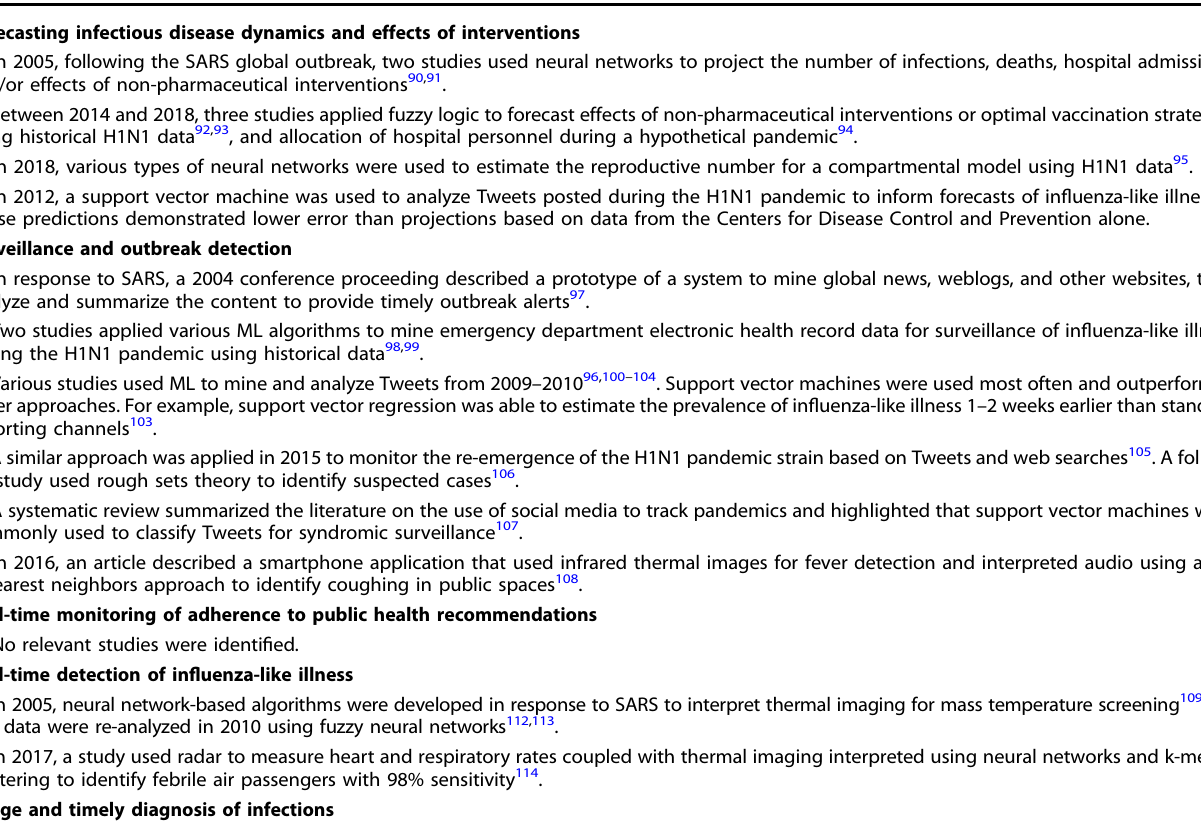
Forecasting infectious disease dynamics and effects of